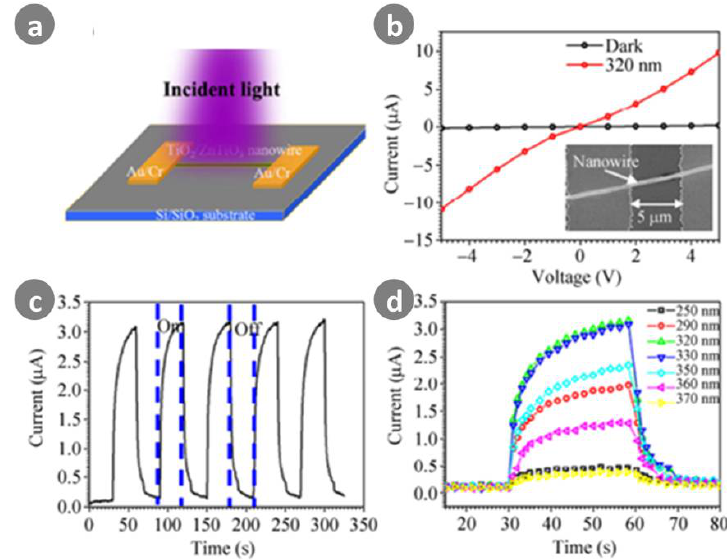
Figure 14. ( a ) Schematic of single TiO 2 -ZnTiO 3 nanowire-based photodetector; ( b ) I–V curves of a single nanowire-based photodetector; inset is a corresponding SEM image of the device; ( c ) Reproducible on/off switching illuminated by 320 nm light with intensity of 186.2 µW/cm 2 at a bias of 2 V; ( d ) Spectroscopic photoresponse of the photodetector under UV illumination under light with varying wavelengths (250 nm: 208.5 µW/cm 2 , 290 nm: 185.5 µW/cm 2 , 320 nm: 186.2 µW/cm 2 , 330 nm: